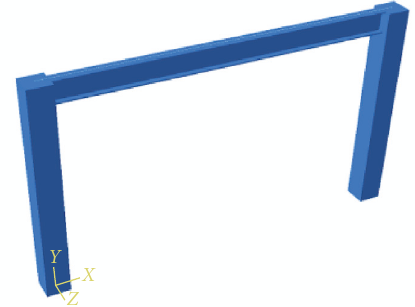
Figure 1: Finite element model of a hybrid frame.